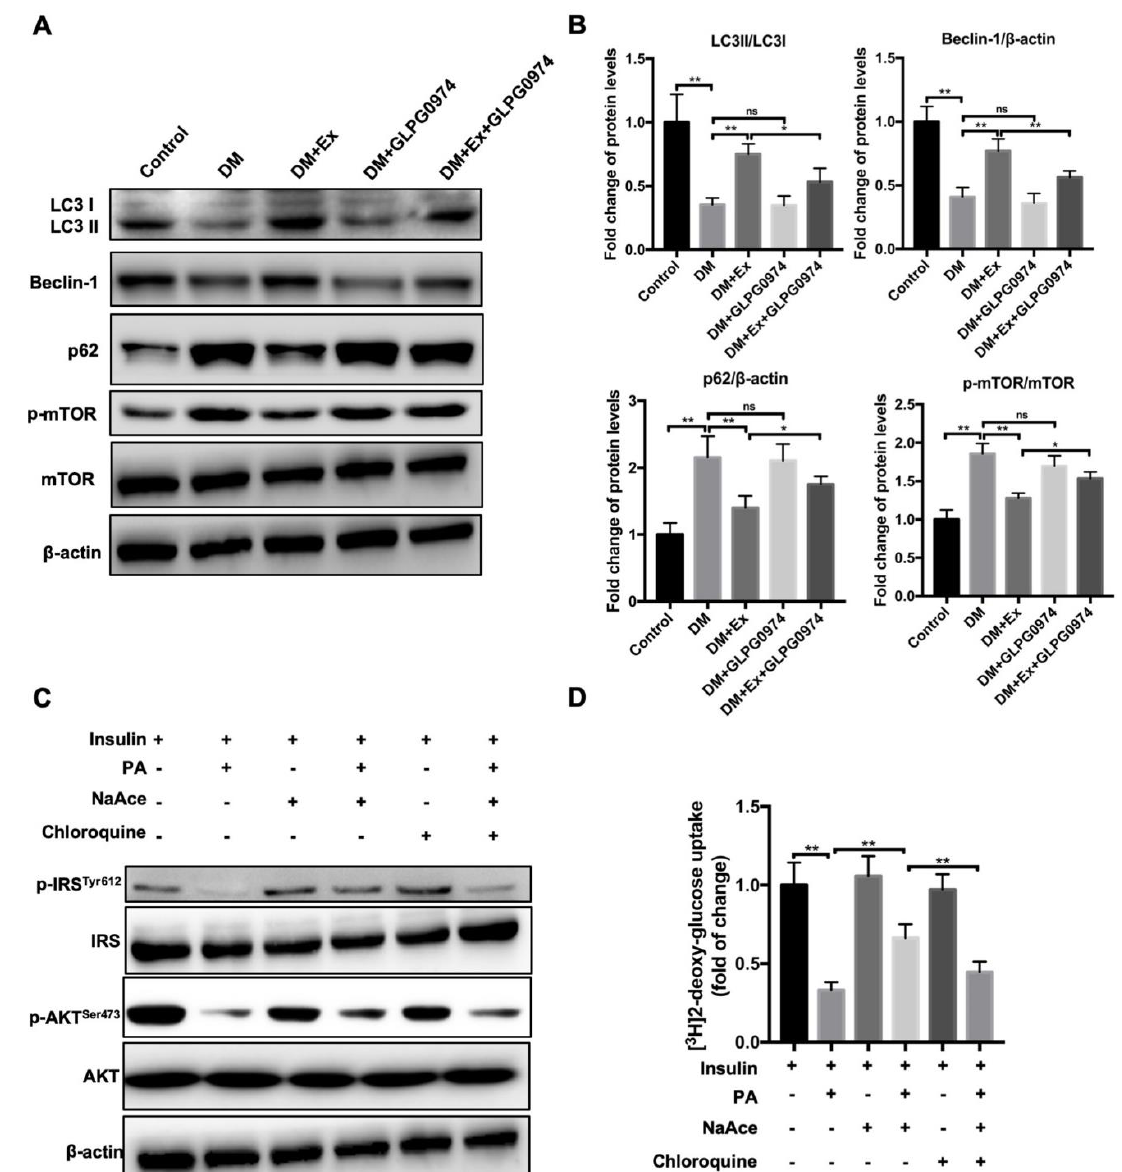
Figure 5. Exercise-mediated SCFAs changes ameliorate IR mainly by increasing autophagy in skeletal muscle cells. ( A ) Primary skeletal muscle cells were isolated from the mice of di ff erent groups including control, DM, DM + Ex, DM + GLPG0974 and DM + Ex + GLPG0974. The expression of autophagy-related proteins p62, LC3, Beclin1, p-mTOR and mTOR in di ff erent groups was analyzed by western blot; ( B ) quantitative analysis of the ratio of LC3II / LC3I, p-mTOR, Beclin 1 and p62 in the left panel ( A ); ( C ) primary skeletal muscle cells were isolated from wild type mice. The insulin resistance skeletal muscle cells were established by the addition of palmitate (PA). Autophagy flux was blocked by the administration of chloroquine. The p-IRS Tyr612 , IRS, p-AKT Ser473 and AKT expression in di ff erent treatment groups were determined by western blot; ( D ) glucose uptake capacity of cells in each group measured by fluorescently labeled 2-deoxyglucose (2-NBDG). * p < 0.05. ** p < 0.01.